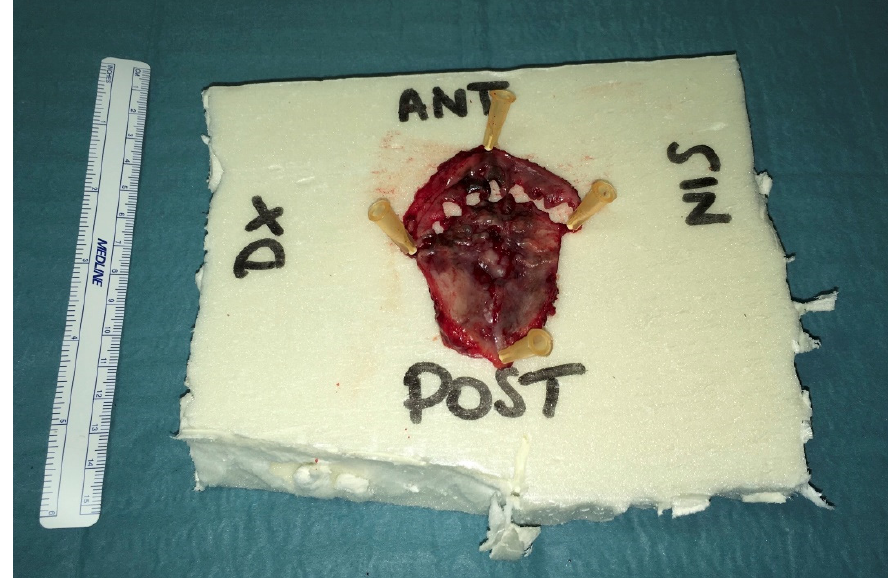
Figure 5. Resected mucosa of the hard palate and maxillary gum with macroscopic evidence of pathological tissue in the alveolar ridge proximal to the melanotic lesion; in addition, seven teeth adjacent to the lesion were removed in order to permit complete resection of pathological tissue. Ant = anterior, Post = posterior; Dx = right; Sin = left.